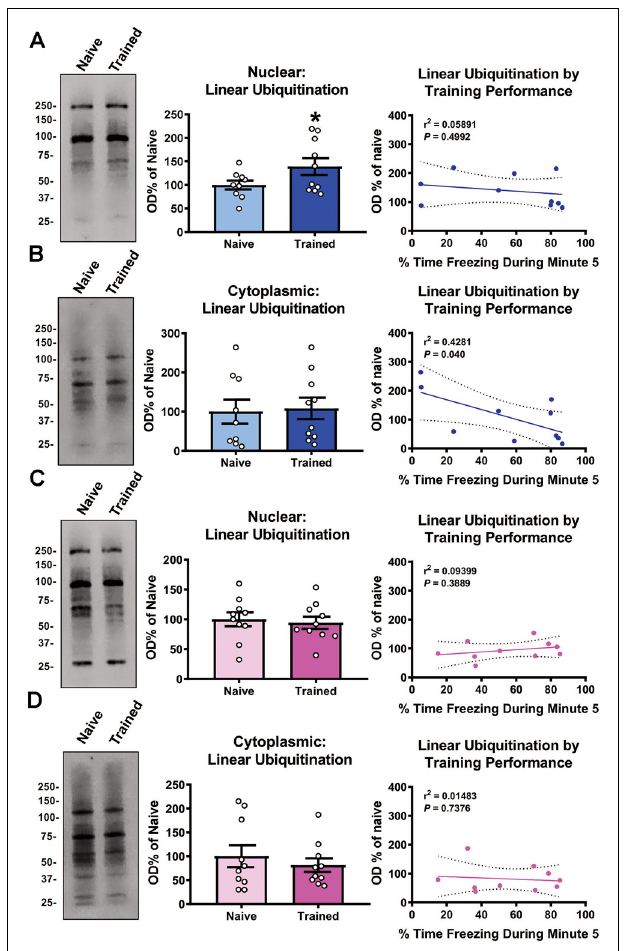
FIGURE 1 | Global levels of nuclear linear polyubiquitination are increased in the amygdala of male, but not female, rats following fear conditioning. Male and female rats were trained on a contextual fear conditioning paradigm and nuclear and cytoplasmic extracts from the basolateral amygdala (BLA) were collected 1 h later for protein analysis. These samples were compared with BLA tissue collected from naïve rats. (A,B) In males, linear polyubiquitination was increased in the nucleus (A) , but not cytoplasm (B) , of BLA cells following fear conditioning. (C,D) In females, levels of linear polyubiquitination were not altered in the nucleus (C) or cytoplasm (D) of BLA cells following fear conditioning. Correlational analyses between linear polyubiquitination levels in the Trained group and the final minute of the training session are shown to the right of each bar graph. All western blots were normalized to Coomassie blue stain on the membrane. N = 9–10 per group per sex. * P < 0.05 from